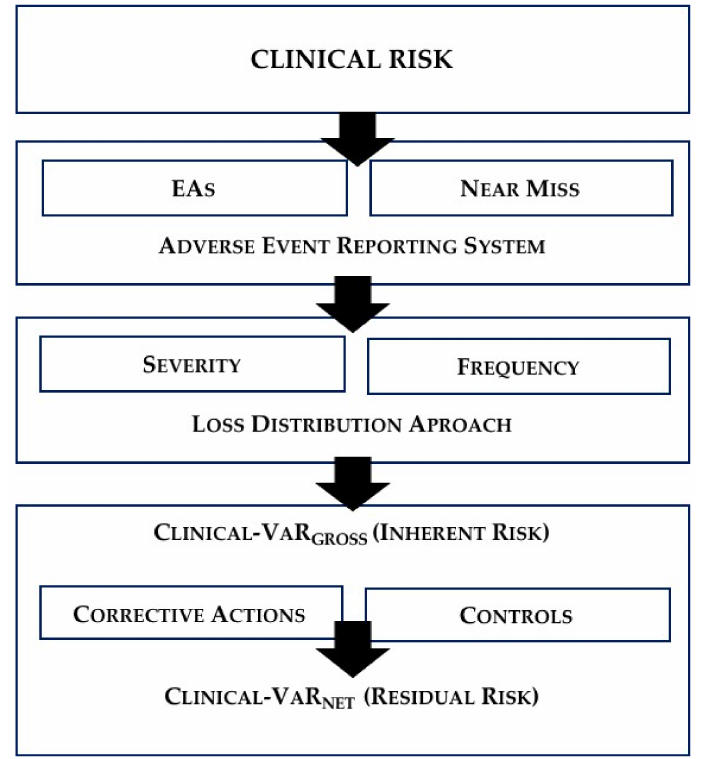
Figure 1. Clinical-VaR